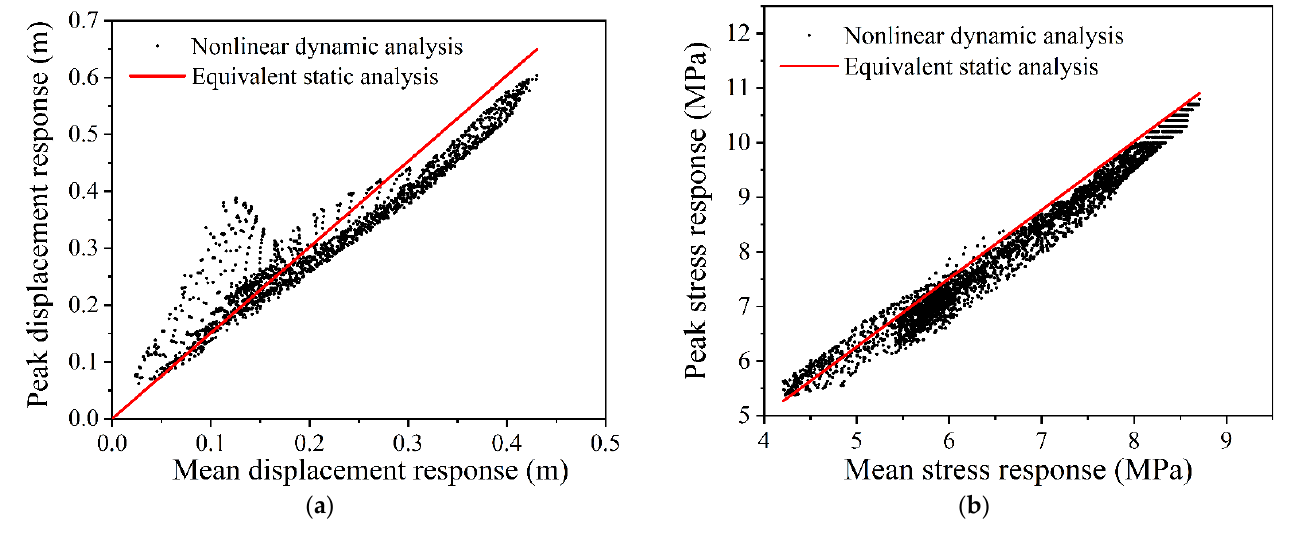
Figure 23. Comparisons between the equivalent response results and nonlinear dynamic analysis results: ( a ) Displacement; ( b ) Stress.